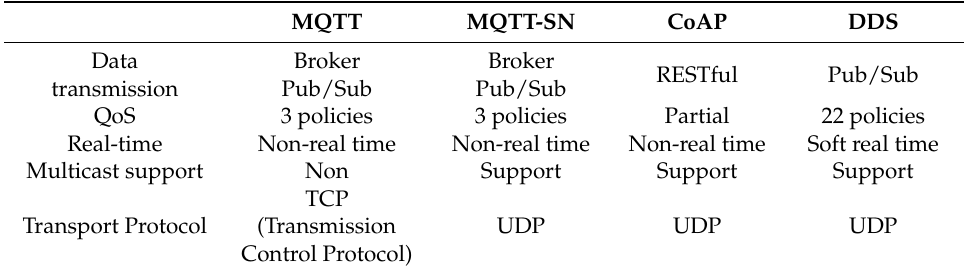
Table 1. Functional Comparisons of IoT